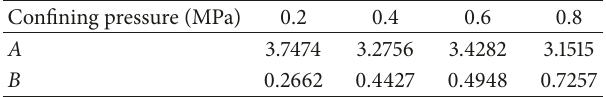
Table 5: A and B values under different confining